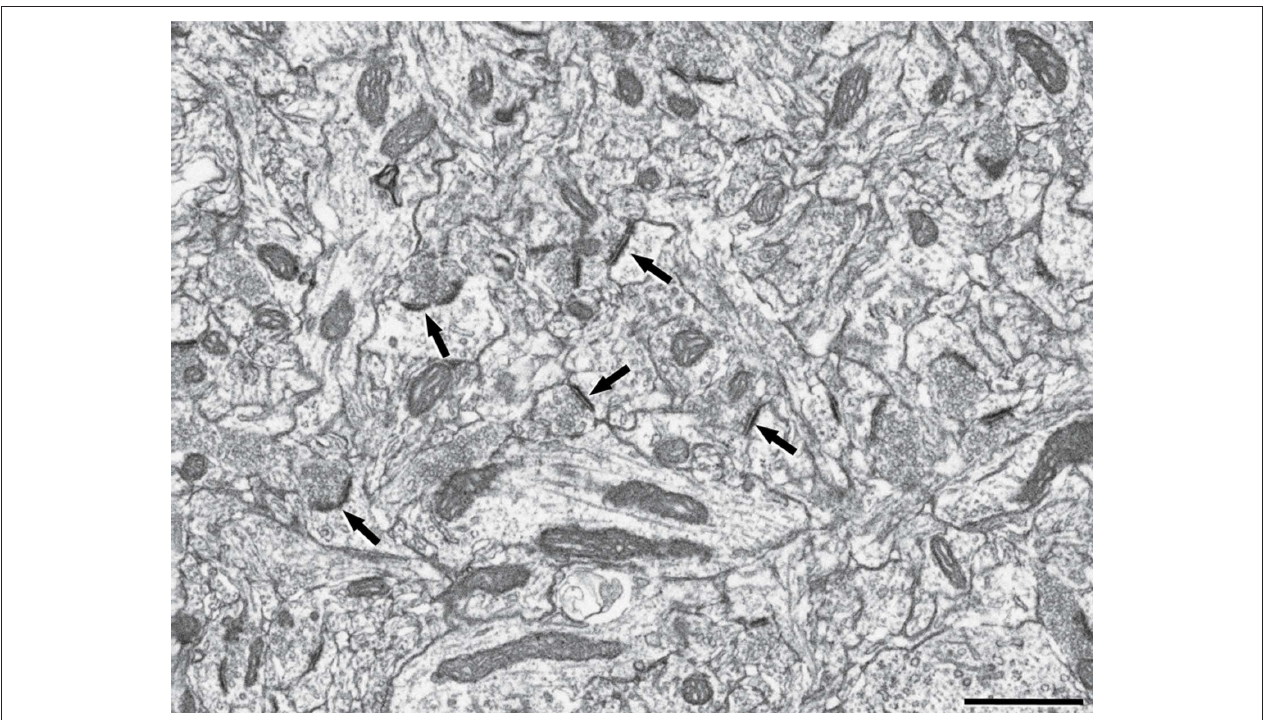
Figure 1 | image captured by focused ion beam milling and scanning electron microscopy (FiB/SeM) showing numerous synapses in the rat cerebral cortex. Some asymmetric synapses are indicated by arrows. Scale bar: 1 μm.